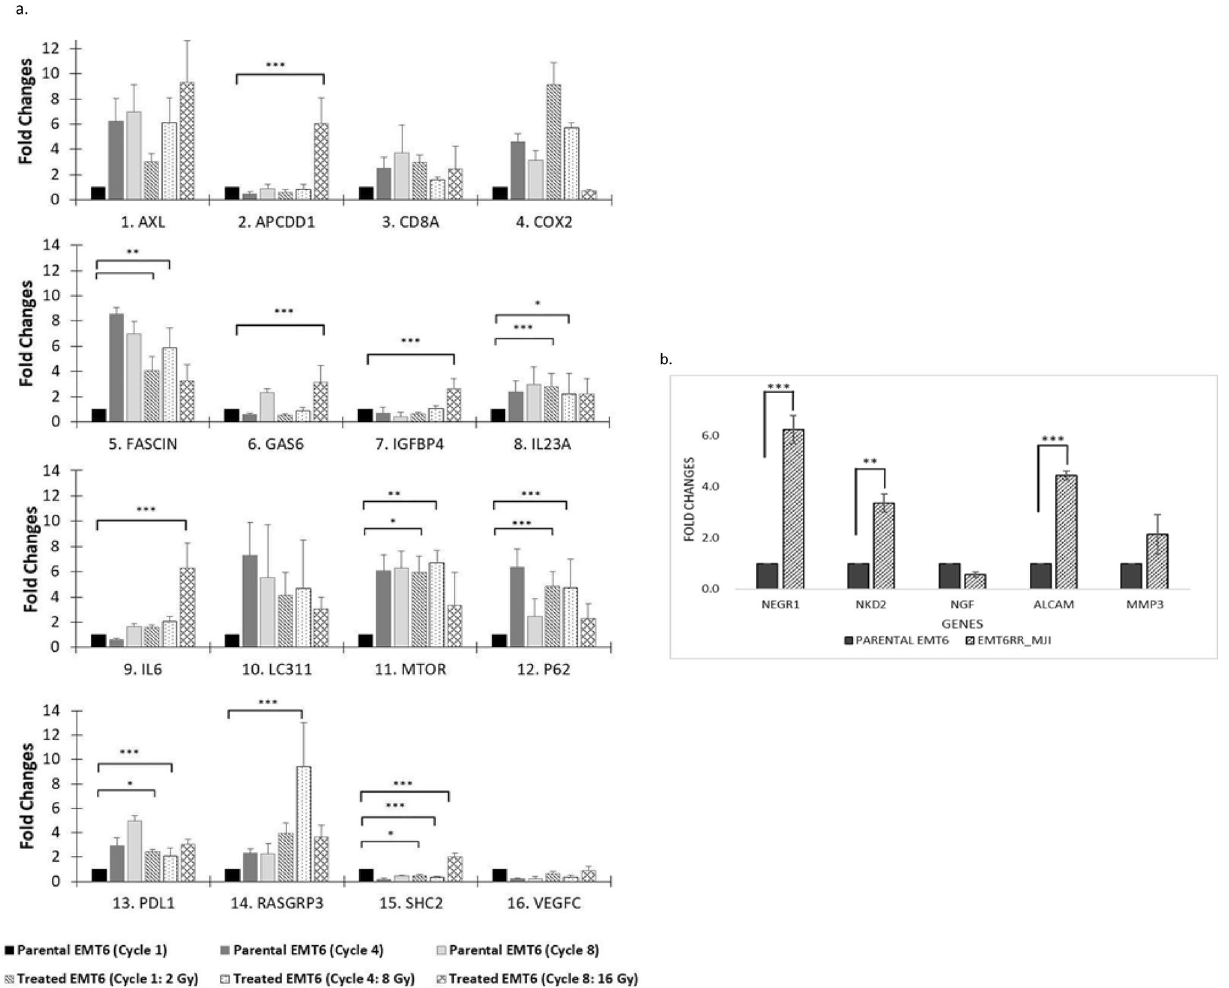
Figure 5. ( a,b ) The expression of target genes associated with acquired radioresistance in EMT6 RR_MJI and parental cells was validated by RT-PCR. ( a ) The expression of selected genes that have tenfold changes based on NGS analysis at 1, 4 and 8 cycles between EMT6 RR_MJI and parental cells: ( b ) The expression of genes exclusively expressed in EMT6 RR_MJI compared to parental cells at 8th cycle; *p < 0.05 vs 0 Gy (1st cycle), **p < 0.01 vs 0